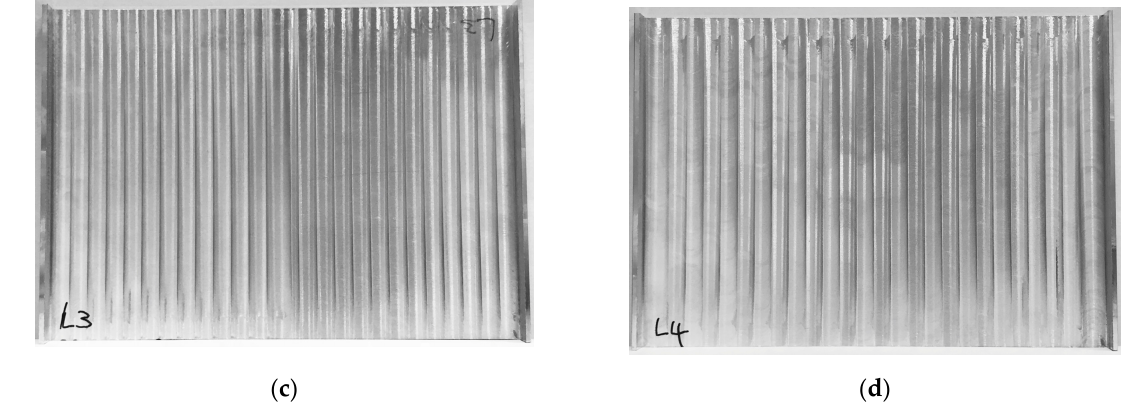
Figure 8. The surface roughness of experimental groups 1 to 4 (N1). ( a ) A1B1C1D1E1, Ra = 0.2 µ m. ( b ) A1B2C2D2E2, Ra = 0.906 µ m. ( c ) A1B3C3D3E3, Ra = 1.869 µ m. ( d ) A1B4C4D4E4, Ra = 1.518 µ m.